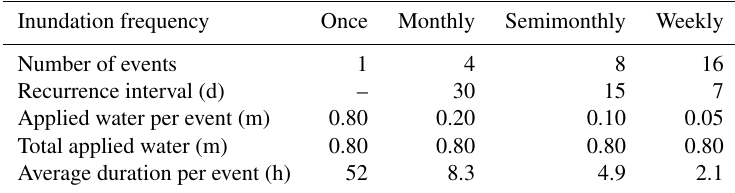
Table 2. Inundation scenarios used for flood-MAR. Inundation frequency